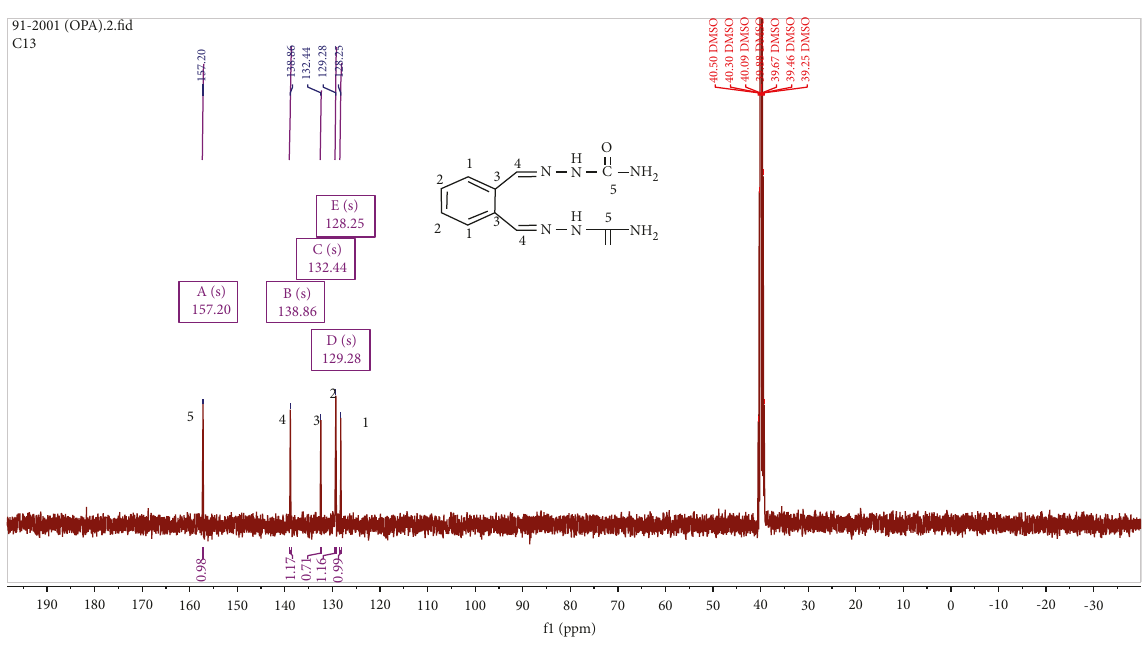
Figure 9: 13 C-NMR graphical spectra of L